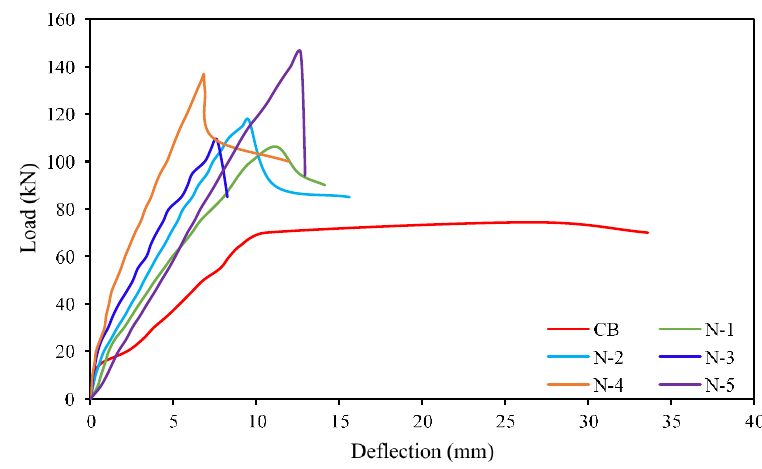
Figure 3. Load vs. deflection at midspan for all beams.